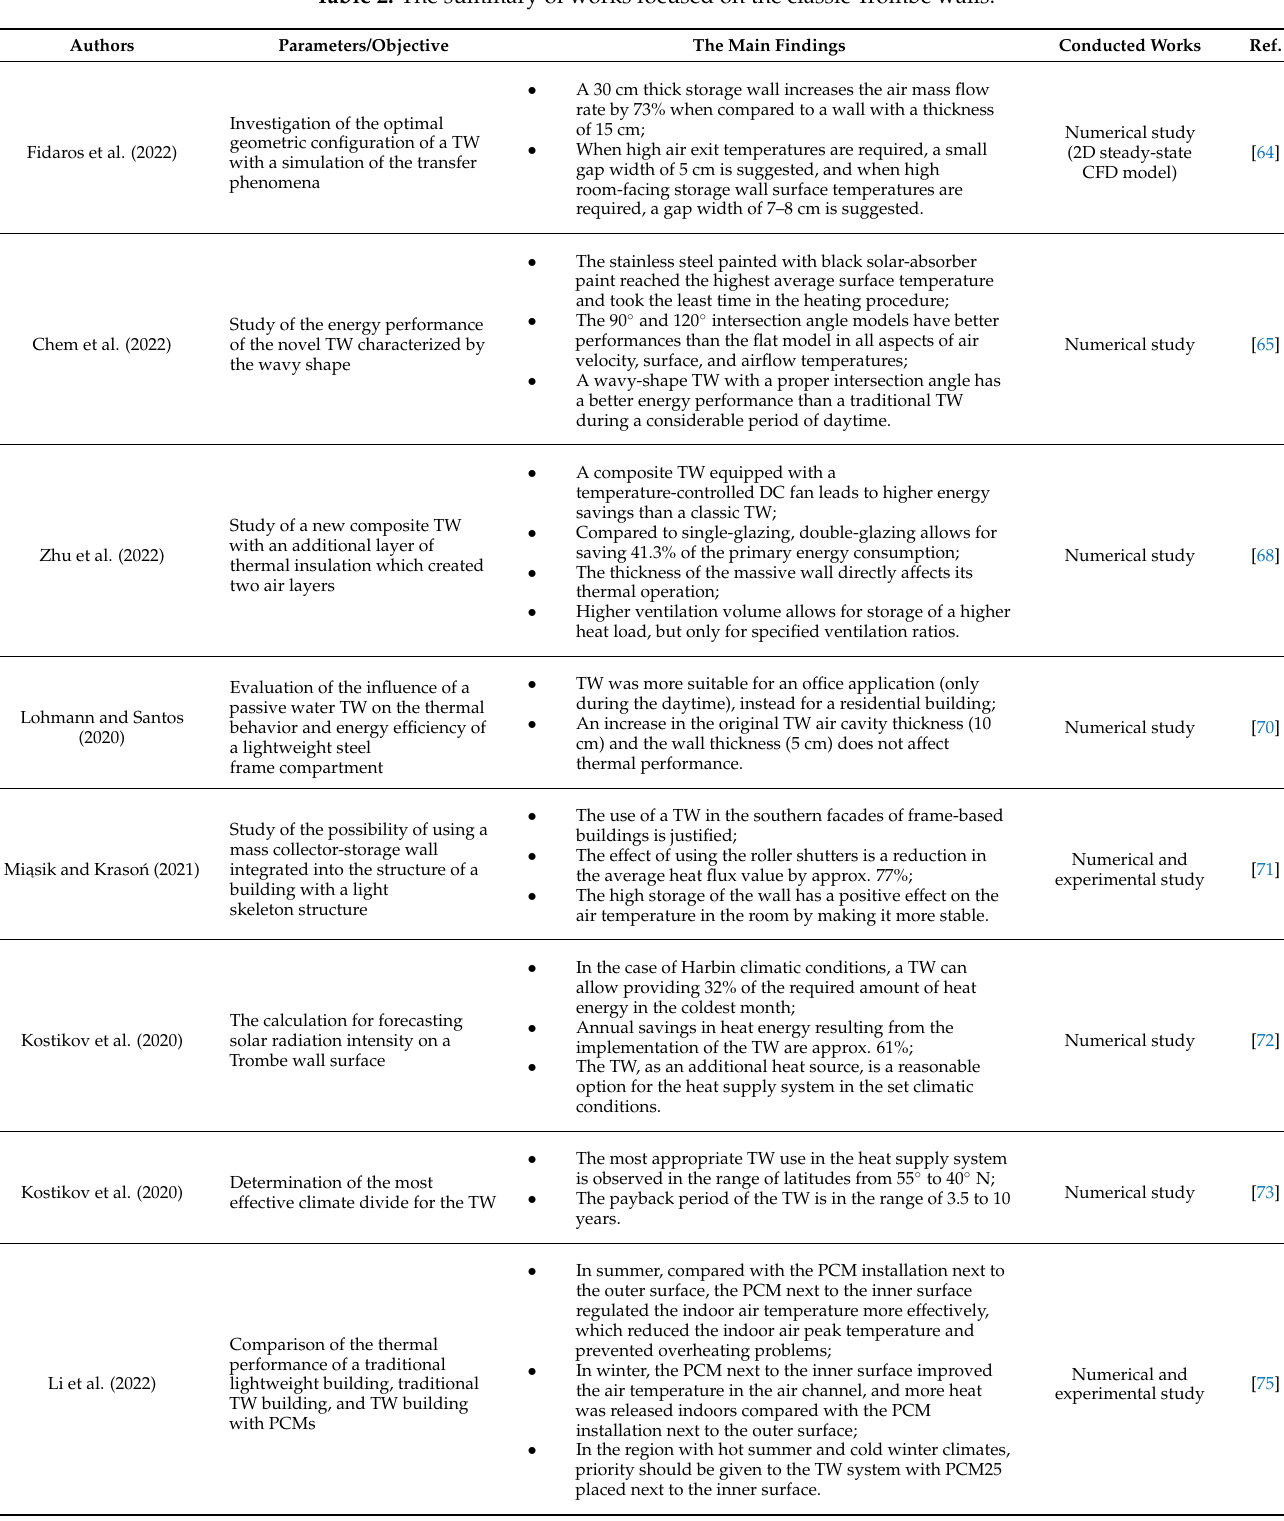
Table 2. The summary of works focused on the classic Trombe